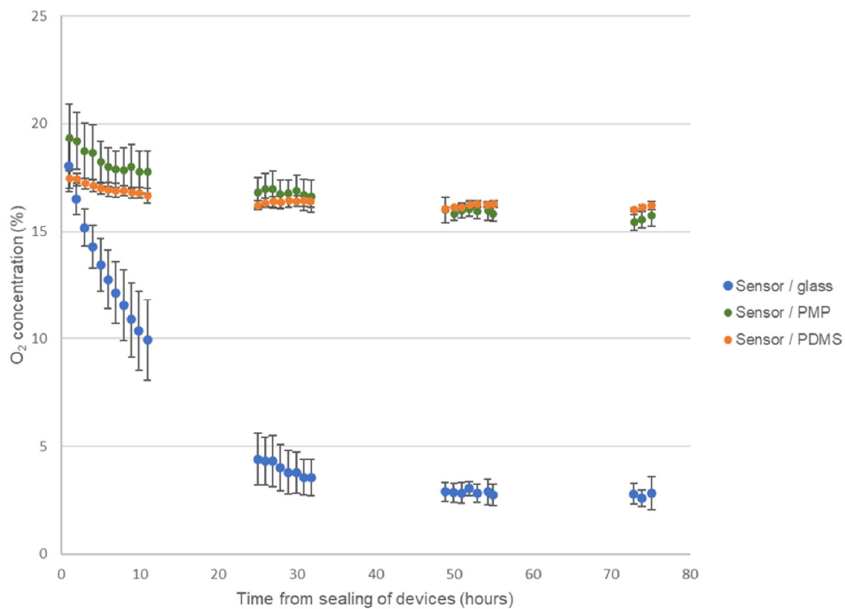
Figure 7. Monitoring of oxygen concentration. Results from monitoring the oxygen concentration during four days of culture of A549 cells in the three different device versions of the culture chamber module, sensor/glass, sensor/PMP and sensor/PDMS (see Figure 2 and Section 2.2.1 for details on device designs). Data are presented as average ± SD, n = 3–5.